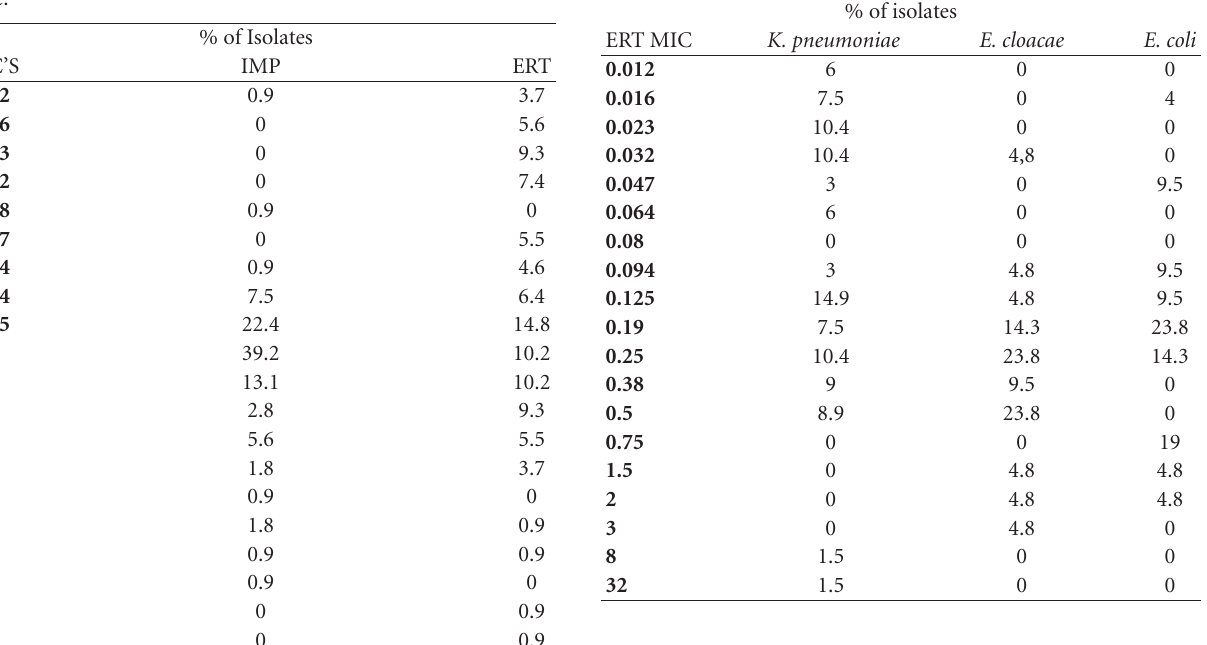
Table 4: Ertapenem (ERT) MICs distribution of 03 main species of